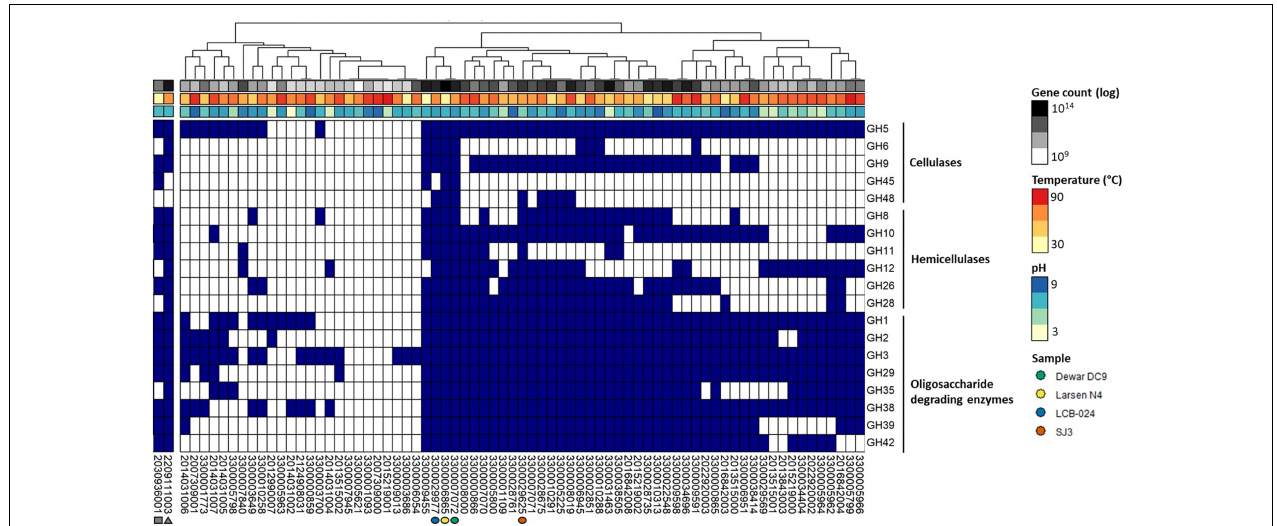
FIGURE 3 | Heatmap showing presence-absence of specific CAZymes with predicted cellulase, hemicellulase, and oligosaccharide-degrading enzyme activities in the 71 metagenomes. Dark blue color represents the presence of a CAZyme gene sequence. Sample clustering was based on hierarchical cluster analysis of dissimilarity of the CAZyme presence-absence profile. Two metagenomes from non-hot spring lignocellulolytic environments are shown on the left and indicated with a gray square (2030936001— Nasutitermes corniger P3 gut compartment) and triangle (2209111003—São Paulo Zoo compost). Four hot spring metagenomes of particular interest to this study are indicated with colored circles. 3300029977—LCB-024—blue, 3300006865—Larsen N4—yellow, 3300007072—Dewar Creek DC9—green, and